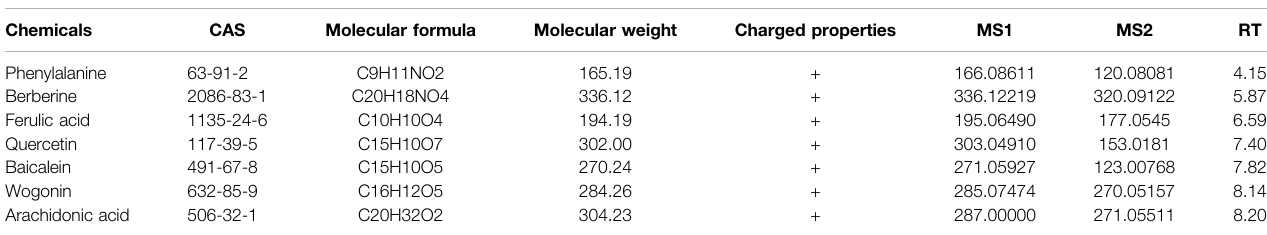
TABLE 2 | Seven chemicals found in